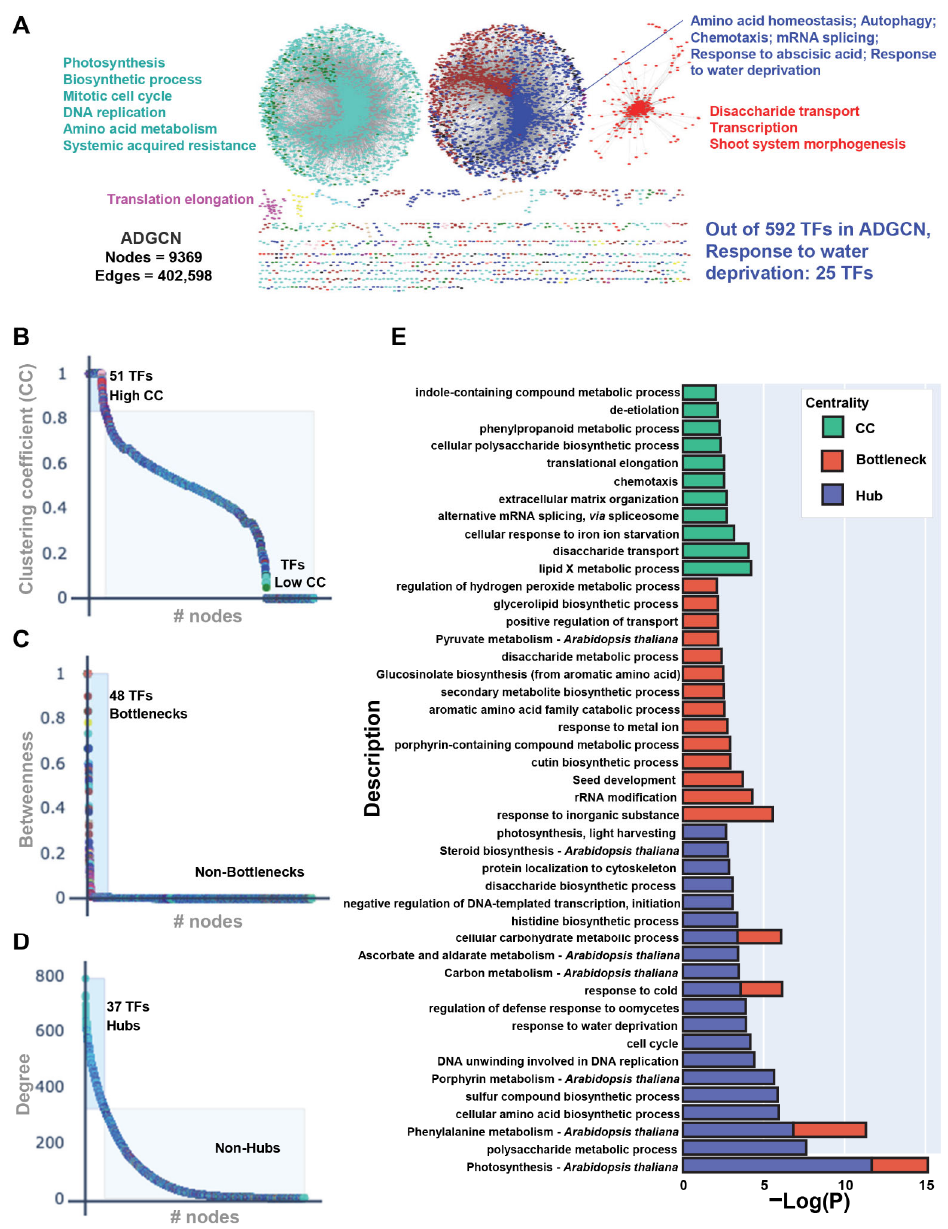
Figure 2. ( A ) Weighted gene co-expression network analysis (WGCNA) constructed the Arabidopsis Drought-specific Gene Co-expression Network (ADGCN) encompassing 9370 nodes connected by 402,598 weighted edges ( ≥ 0.75). Nodes are colored based on their specific module assignment. Most significant modules based on connectivity and clustering coefficient were annotated by GO analysis and the enriched pathways are listed next to their respective modules ( p -value ≤ 0.05). ( B – D ) ADGCN network analysis plots displaying clustering coefficient (CC) ( B ), betweenness centrality ( C ), and degree distribution ( D ). ( E ) Functional annotation and pathway enrichment analyses of high CC (green), high bottleneck (red), and high hub (violet)